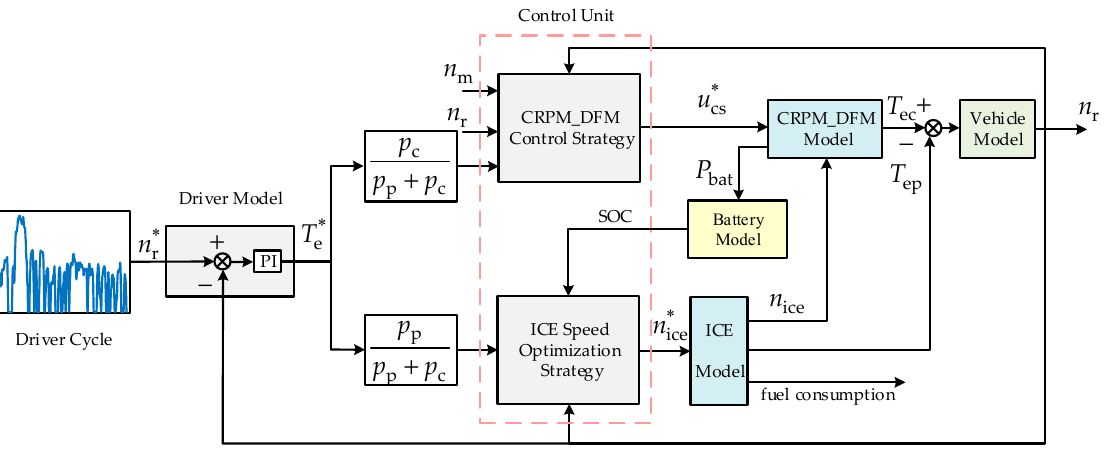
Figure 14. The system block diagram of EREV system based on CRPM-DFM.